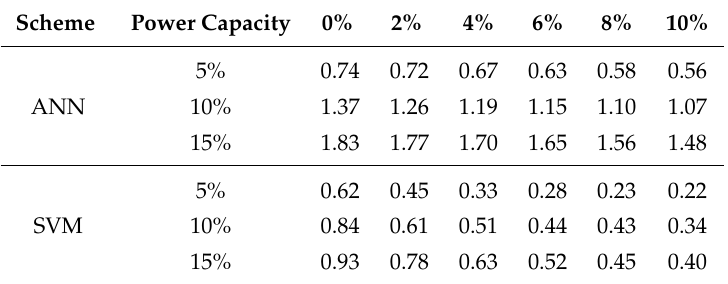
Table 4. Energy capacity [p.u.] of both the ANN and SVM schemes with different tolerance limits. Scheme Power Capacity 0% 2%